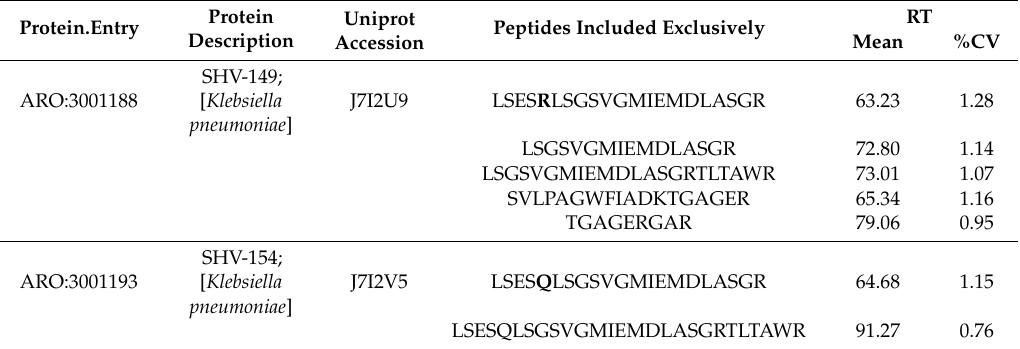
Table 3. J7I2U9 and J7I2V5 β -lactamase isoforms specific peptides. Peptides exclusively related to J7I2U9 and J7I2V5 β -lactamase isoforms are reported.